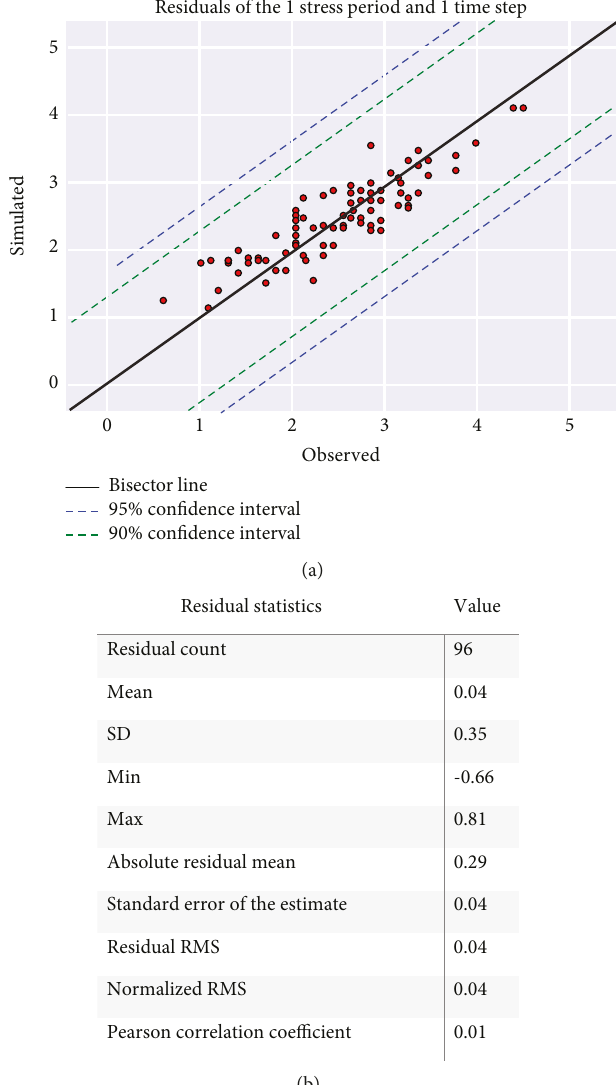
Figure 7: Comparison between observed and simulated head values and statistics on